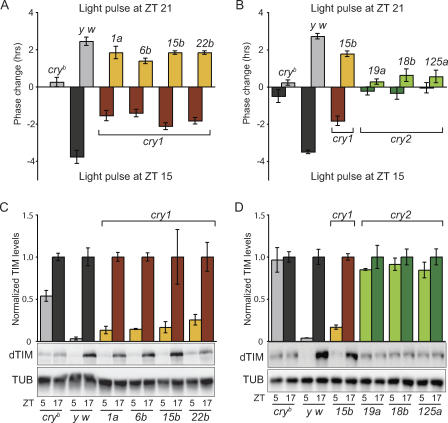
Transgene Expression of Monarch cry1 Partially Rescues cryb Defects(A) Expression of monarch CRY1 in a cryb background partially rescues phase advances and delays after a 1-h light pulse at ZT 21 or ZT 15, respectively. Four independent UAS-cry1 lines—designated 1a, 6b, 15b, and 22b—were examined. Expression of the transgenes was driven by tim-GAL4. Phase changes: positive numbers are advances, negative numbers are delays. The ZT 21 pulse experiment was performed three times for cryb, y w, 6b, 15b, and 22b, and twice for 1a, using 16 males per genotype per experiment. The ZT 15 pulse experiment was performed four times for cryb, y w, 6b, 15b, and 22b, and three times for 1a, using 16 males per genotype per experiment. Each value is the mean ± SEM. The value for cryb at ZT 15 was 0 with SEM within the width of the horizontal line.(B) Expression of monarch CRY2 in a cryb background does not rescue phase shifts after a 1-h light pulse at either ZT 21 or ZT 15. Three independent UAS-cry2 lines, designated 19a, 18b, and 125a, were examined. The UAS-cry1 line, 15b, was included as a comparison. Expression of all the transgenes was driven by tim-GAL4. The ZT 21 and ZT 15 pulses experiments were performed three times each, using 16 males per genotype per light pulse per experiment. Each value is the mean ± SEM.(C) Expression of monarch CRY1 partially rescues Drosophila TIM cycling in LD. Flies were collected at ZT 5 and ZT 17. Whole head extracts were subjected to Western blot analysis using a Drosophila anti-TIM antibody (top half of blot) or anti-tubulin antibody (bottom half of same blot). The UAS-cry1 lines are the same as in (A). TIM levels at ZT 17 were normalized to 1.0. This experiment was performed three times. Each value is the mean ± SEM.(D) Expression of monarch CRY2 does not rescue Drosophila TIM cycling in LD. The UAS-cry2 lines are the same as in (B). The UAS-cry1 line, 15b, is included for comparison. TIM levels at ZT 17 are normalized to 1.0. This experiment was performed three times. Each value is the mean ± SEM.